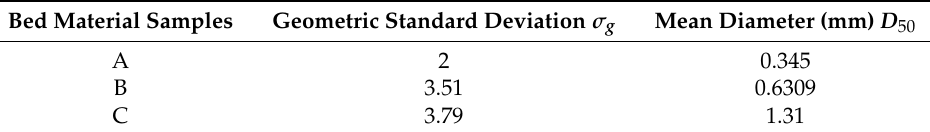
Table 1. The properties of the bed materials used in the experiment.